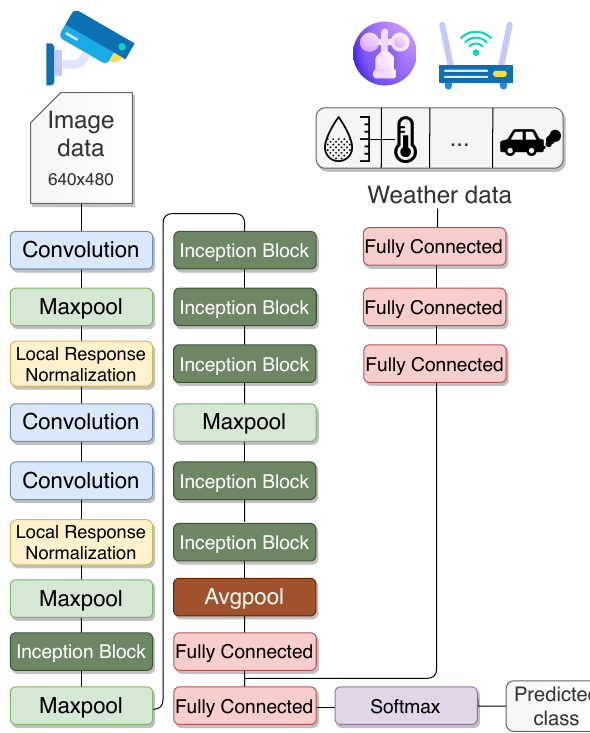
Figure 10. Proposed custom pretrained